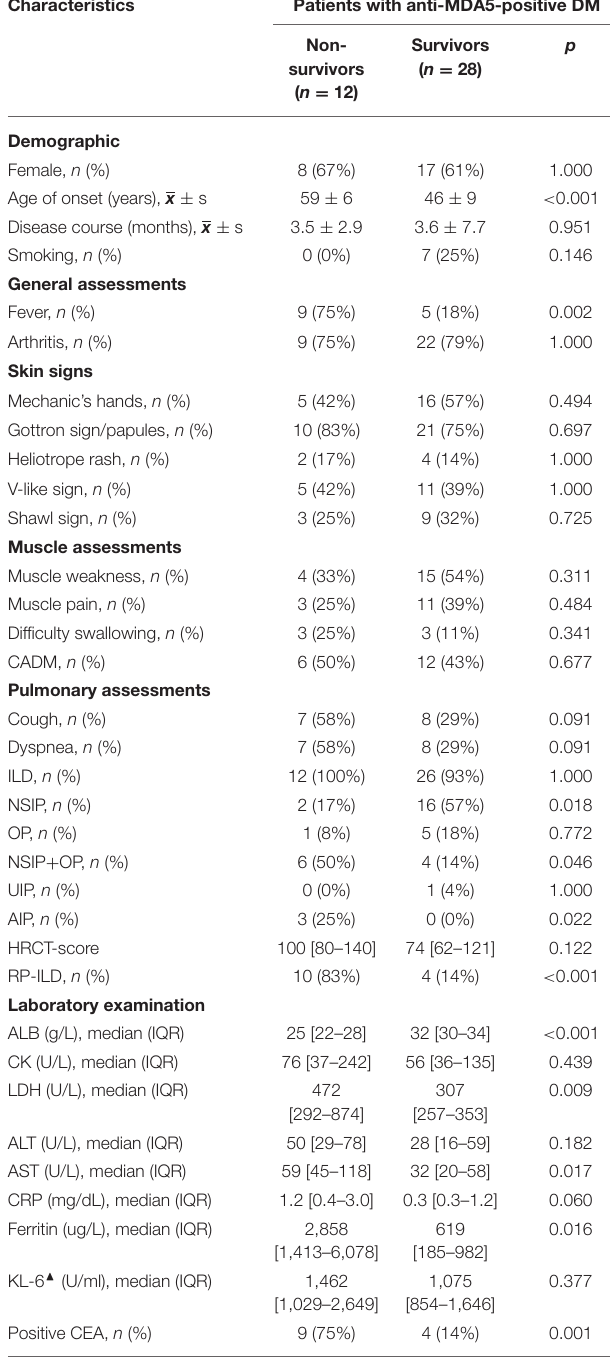
TABLE 3 | Comparisons of clinical characteristics between non-survivors and survivors with anti-MDA5-positive DM.